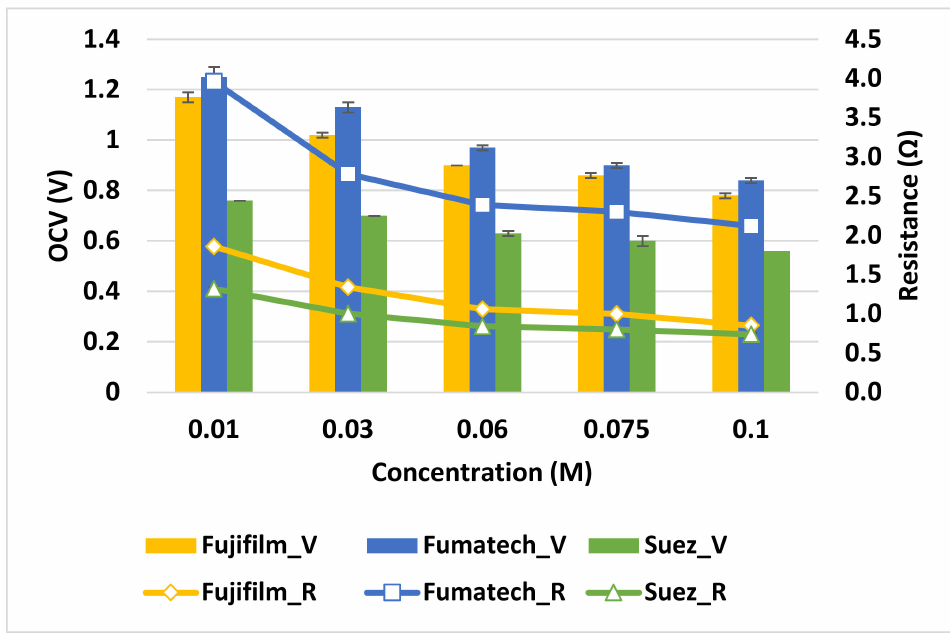
Figure 9. Variation of OCV and stack resistance with dilute concentration under the experimental conditions of 5 mol L − 1 C High , 20 ◦ C temperature and 1 cm s − 1 flow